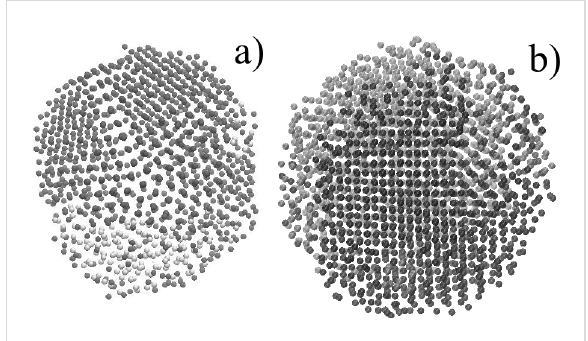
Figure 3: The structure of Cu–Si clusters: a) cooling rate of 1.5 K/ps (IR and DK phases); b) the cooling rate is 1 K/ps (fcc and hcp phases). Light grey: silicon, dark grey: copper.